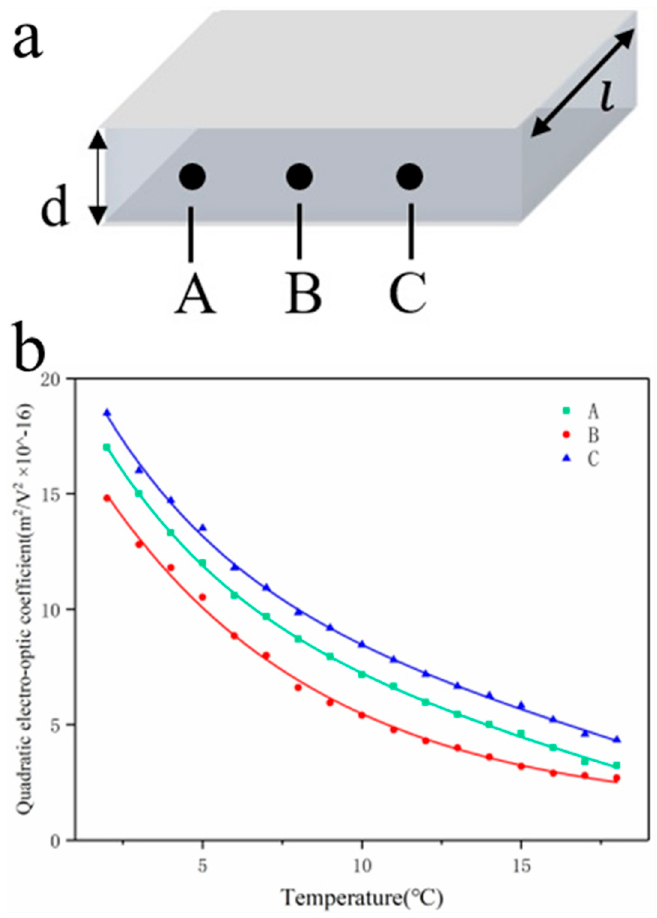
Figure 6. ( a ) The position of A, B, and C on the crystal. ( b ) The quadratic electro-optic coefficients at three different positions of A, B, and C in the range of 2–18 °C (the solid line is the fitting result).